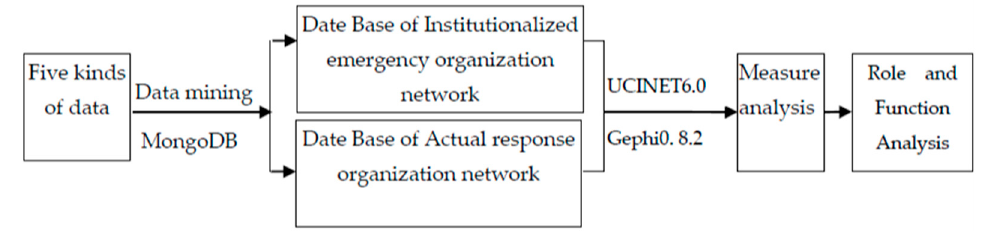
Figure 2. The workflow of case study.